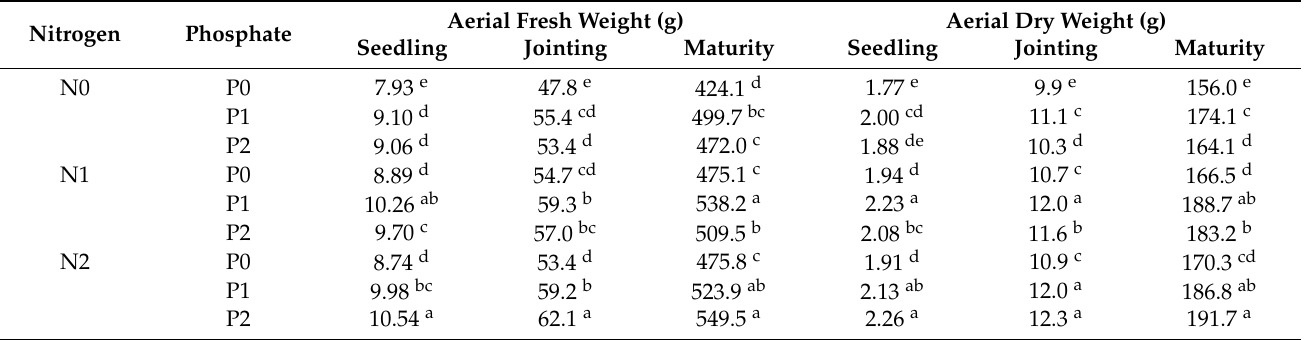
Table 2. Effects of nitrogen and phosphorus on aerial fresh and dry weight of sorghum plants grown in saline soils at the three growing stages of seedling, jointing, and maturity.